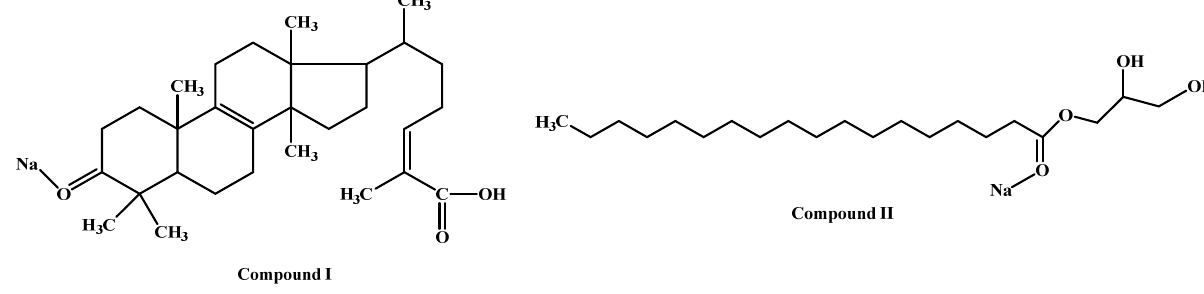
Figure 3. The structures of the proposed compounds based on the data from the ESI-MS analysis.